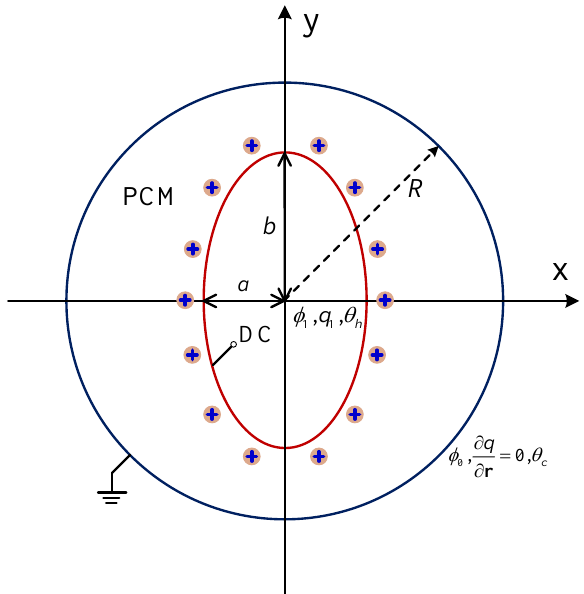
Figure 1. Schematic of EHD melting in a circular-elliptical